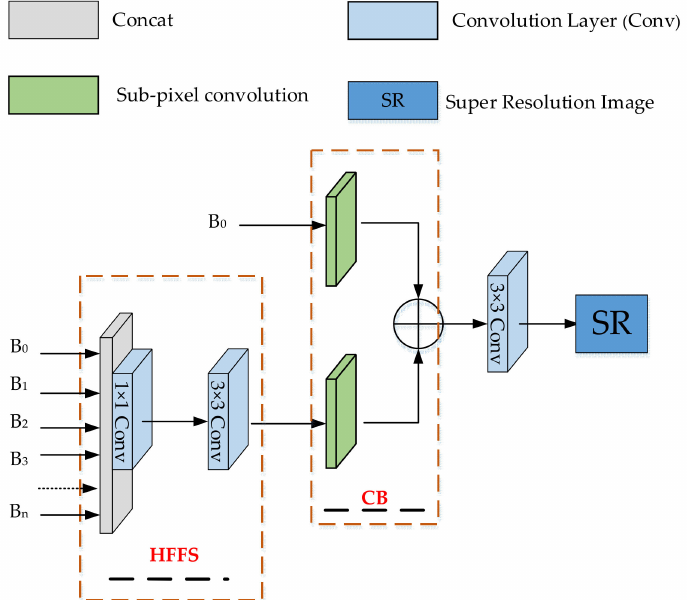
Figure 5. Reconstruction structure of the PMSRN, which mainly consists of the CB module. The CB module input includes two parts, namely, the original image feature information B 0 and the HFFS. The two parts of the input perform sub-pixel convolution operations, and the corresponding elements are added to reconstruct the SR image. The HFFS concatenates the inputs B 0 , B 1 , . . . , and B n and outputs them after two layers of convolutional filtering.